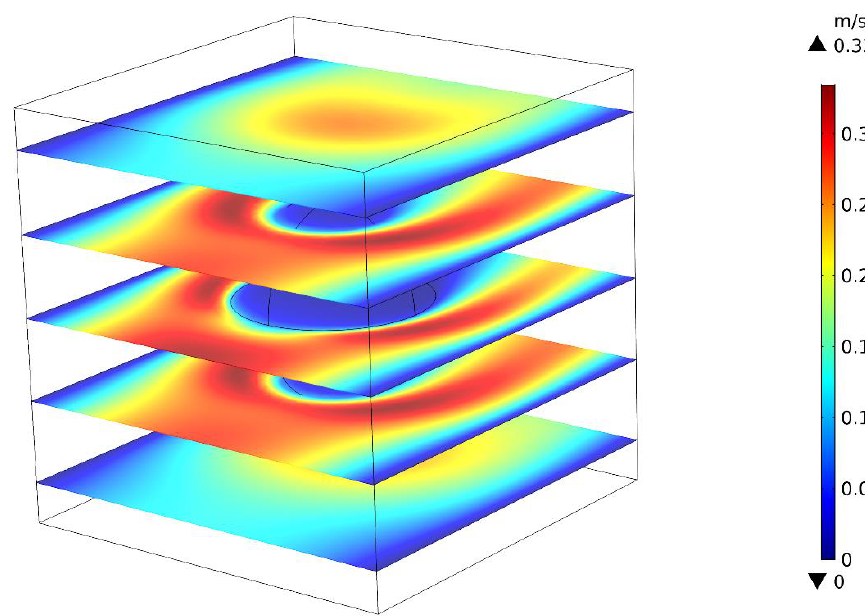
Figure 16. Velocity profiles computed by the 3D particle model for laminar flow.